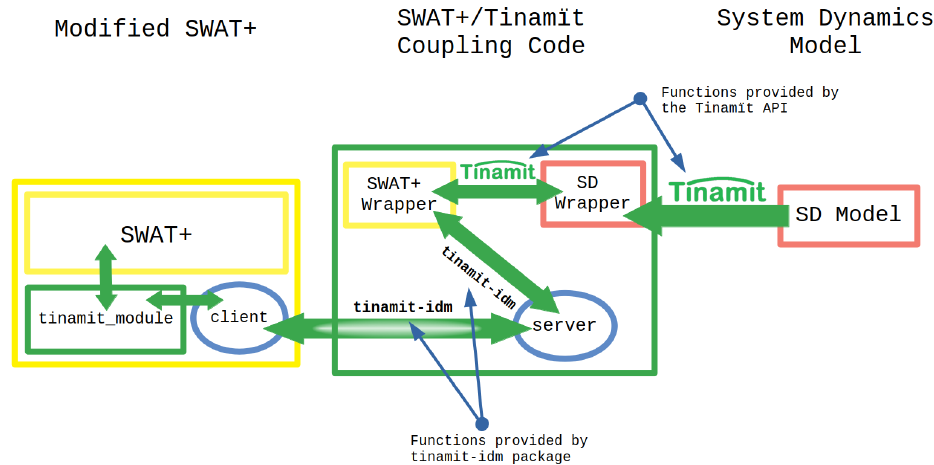
Figure 1. A schematic summary of the coupling process using the pre-existing Tinamït API and the newly developed tinamit-idm Python package. This schematic is adapted and modified from Harms et al. (2020, 2021).